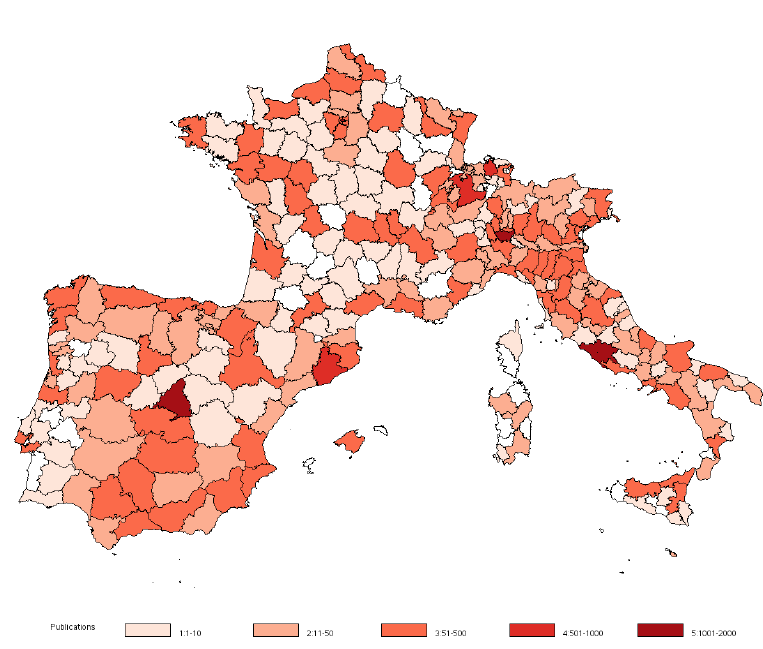
Figure 1b: Publication Output for Cardiovascluar Medical Devices at Regional levels of NUTS-3 in Europe: Switzerland, France, Portugal, Spain, Italy, and Malta